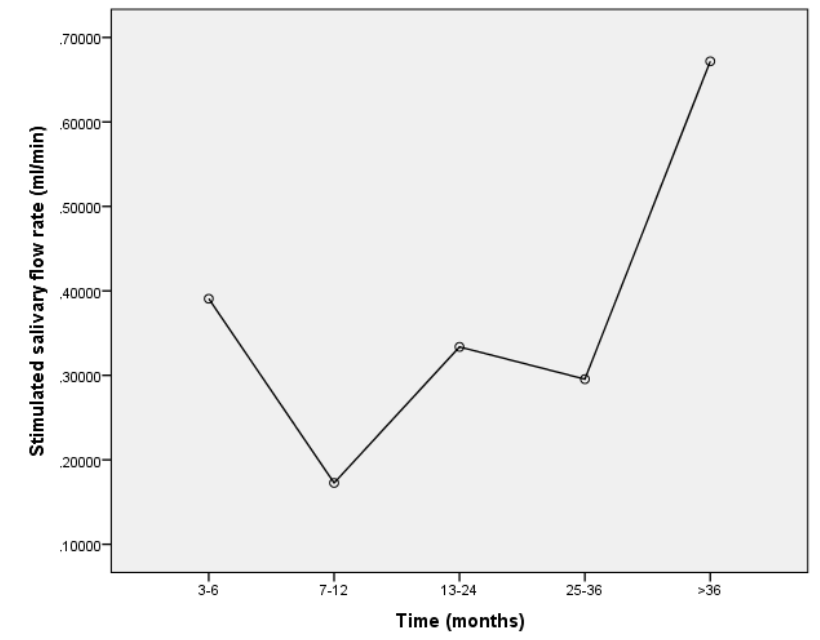
Figure 1- Mean stimulated salivary flow as function of time elapsed since radiotherapy, in the total sample